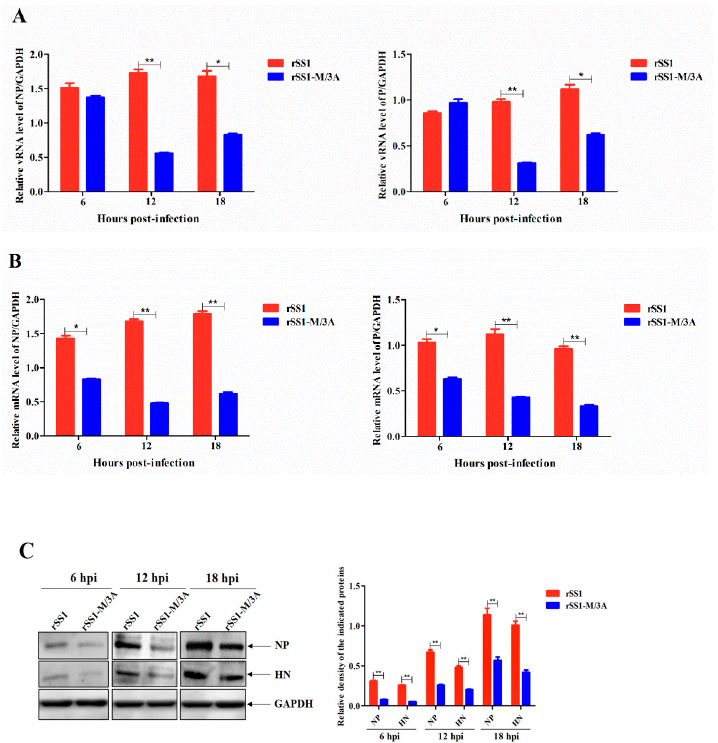
Figure 4. The M/3A protein causes the reduced viral RNA synthesis and transcription of recombinant NDV. ( A ) Viral RNA synthesis and transcription ( B ) corresponding to the NP and P genes in